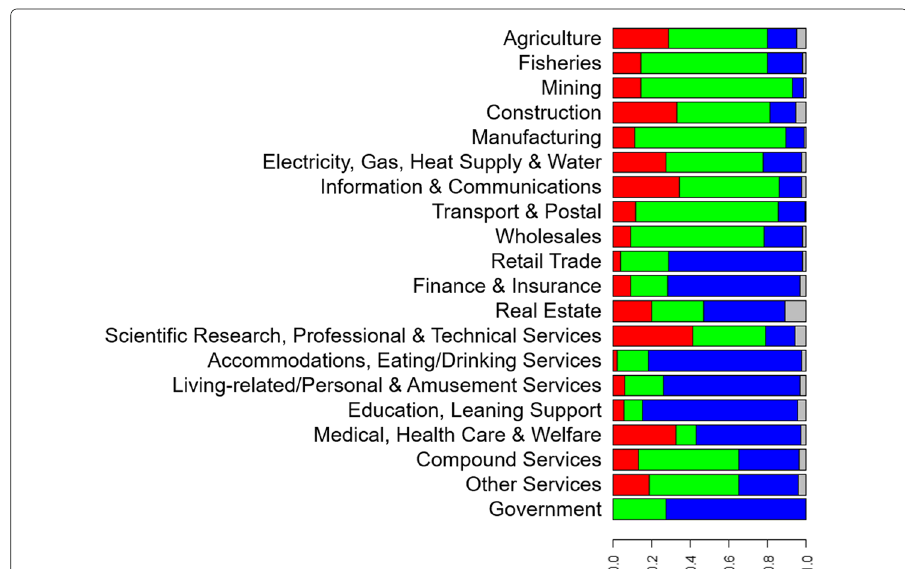
Fig. 5 Distribution of firms in the IN (red), GSCC (green), OUT (blue) and other components (gray) of the TSR transaction network across sectors